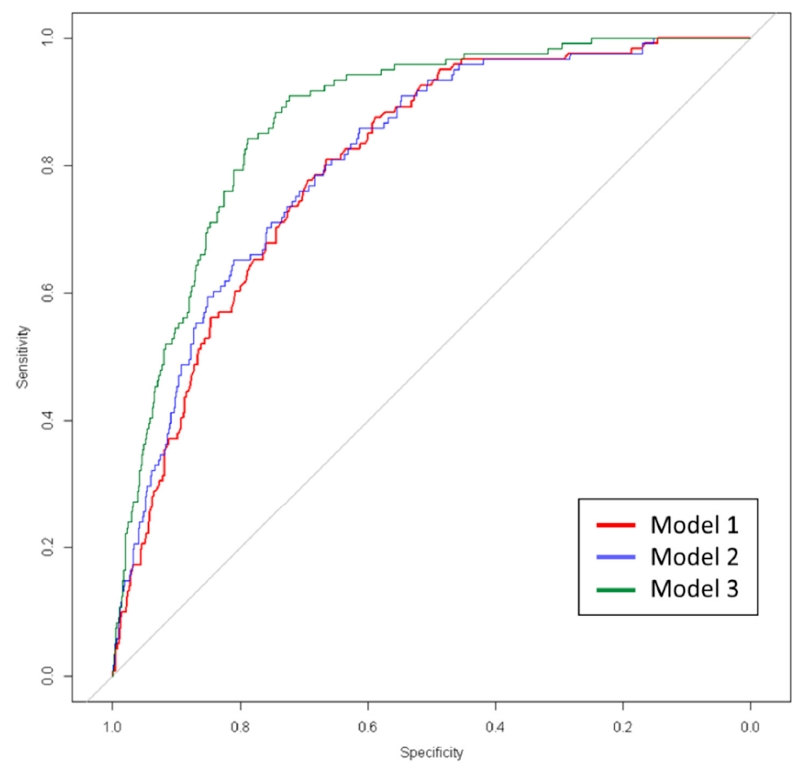
Figure 2. ROC curve of logistic regression for the three models.